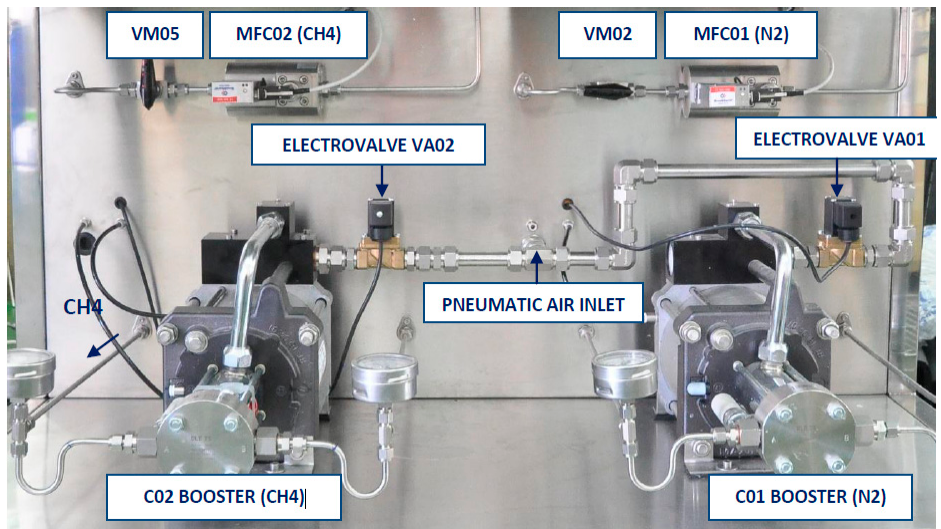
Figure 5. Methane and nitrogen boosters. VM05 and VM02—globe valves; MFC01 and MFC02—mass flow controllers; VA01 and VA02—electrovalve for inlet air control for the booster.